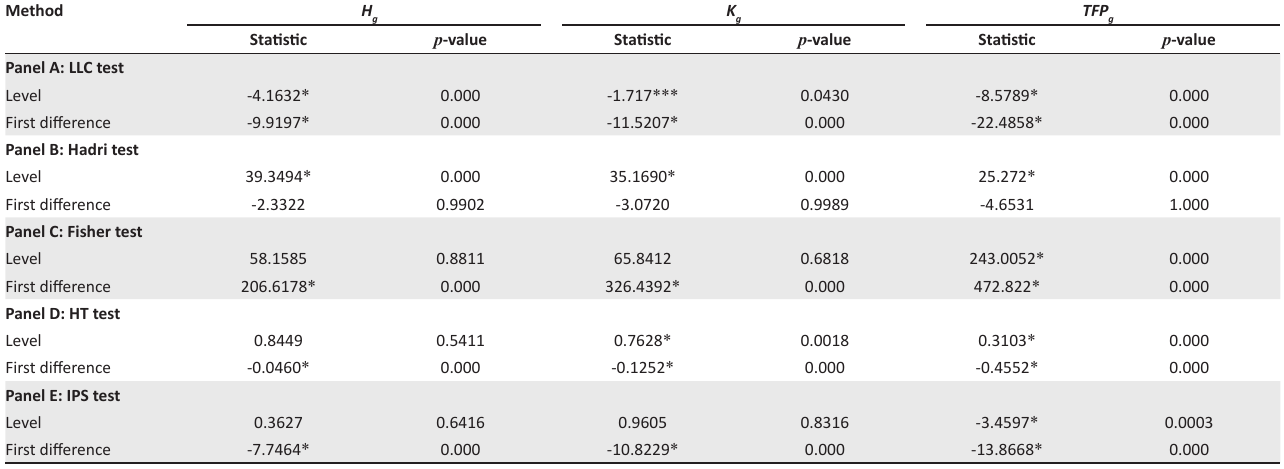
TABLE 7: Unit root results.